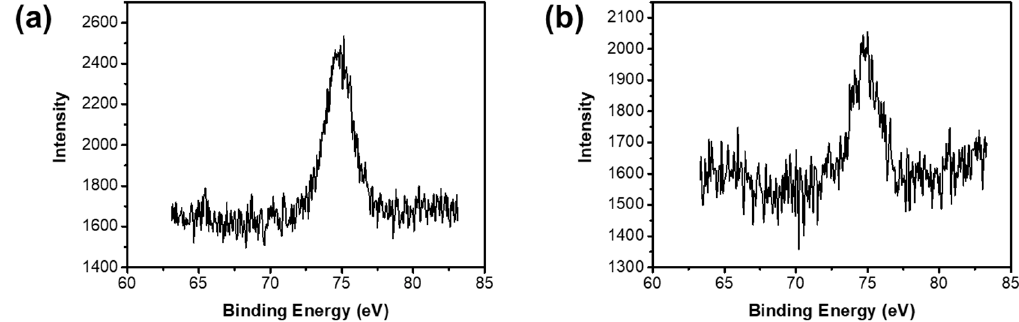
Figure 6. Al2p X-ray photoelectron spectroscopy (XPS) spectra of ( a ) sample A and ( b ) sample A with acid treatment.